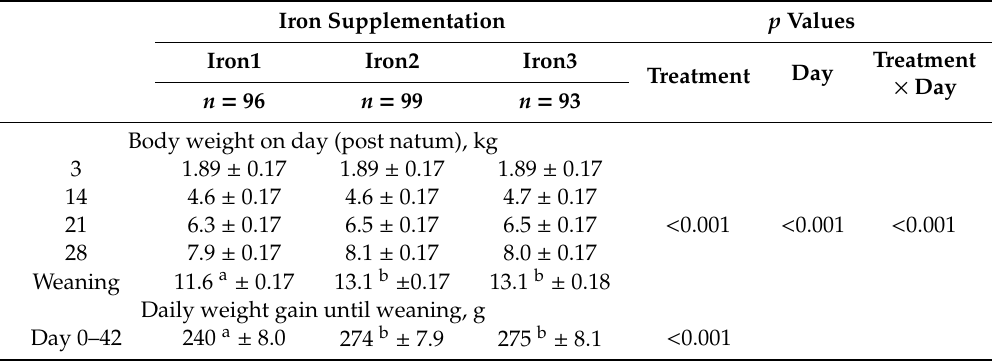
Figure 1. Feed consumption of piglets receiving di ff erent frequencies of iron supplementation. The box-plots show minimum, first quartile, median, upper quartile and maximum values, and the values are given on an as-fed basis. Table 4. E ff ect of supplementing iron by subcutaneous injection to organically reared piglets on their third day of life only (Iron1), on day 3 and 14 (Iron2) and on day 3, 14 and 21 (Iron3) on body weight and daily weight gain until weaning. Results are given as least square estimates ± SEMs of the interaction treatment * day for body weight and least square estimates ± SEMs of the e ff ect of treatment for daily weight gain, and p values for the e ff ects of treatment, day and treatment * day. Analysis was carried out using SAS PROC MIXED.